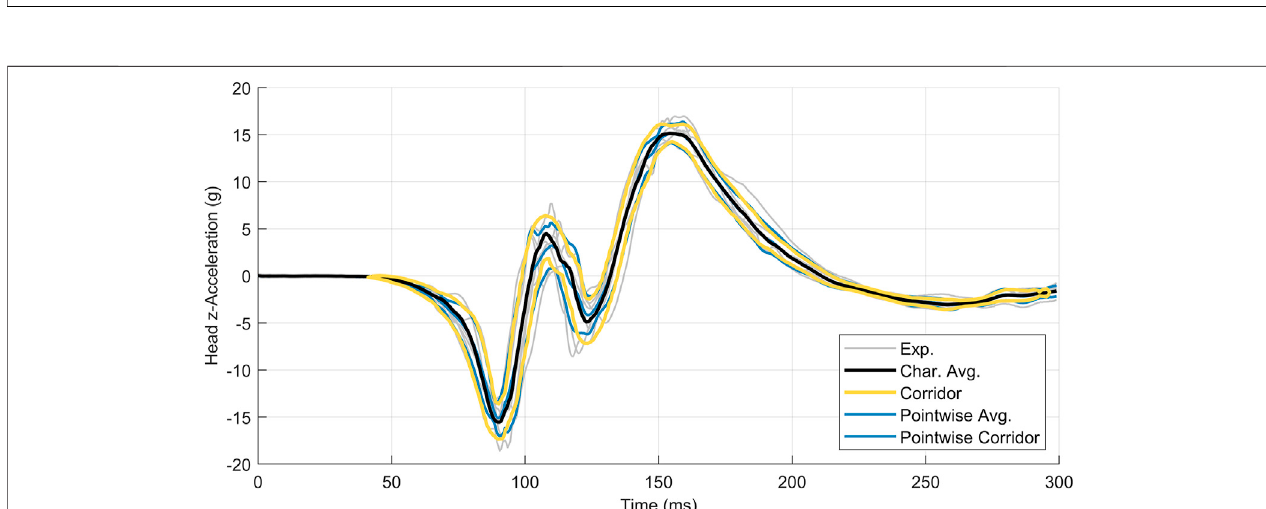
Frontiers in Bioengineering and Biotechnology |